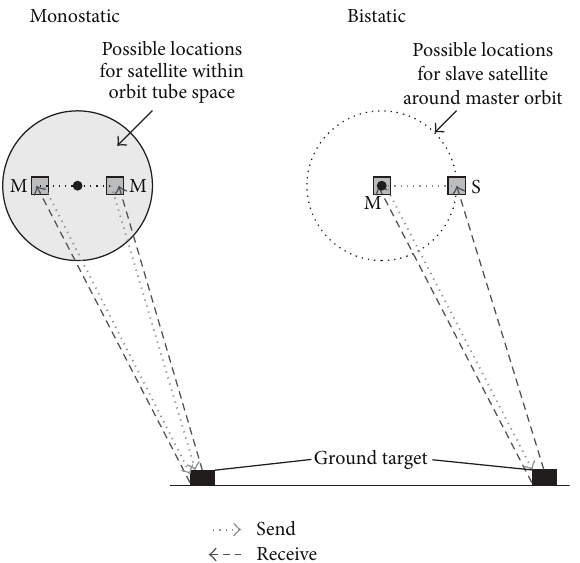
Figure 3: Monostatic (left side) image acquisition on two dates: the satellite ( M ) sends a signal (dotted line) and receives the echo (dashed line) during each overpass. Bistatic image acquisition generates two images in a single overpass with almost no time difference. One satellite serves as transmitter, and both serve as receiving antennas. The baseline of the slave satellite is desired to be on a circle around the master, see Figure 2.